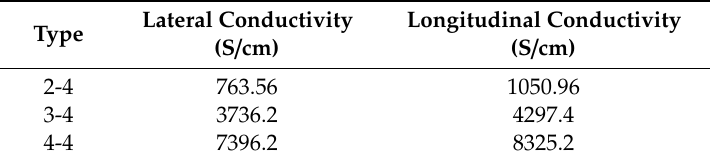
Table 8. Relation between the number of deposition and contact angle.